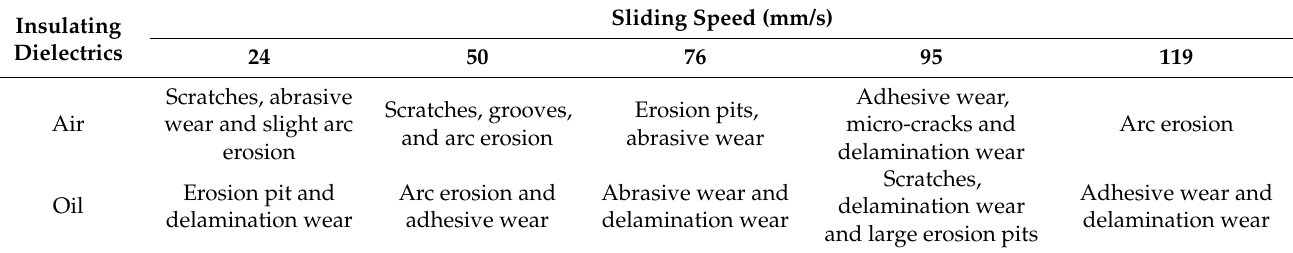
Table 2. Micro-morphology characteristics at different sliding speeds in air and insulating oil.